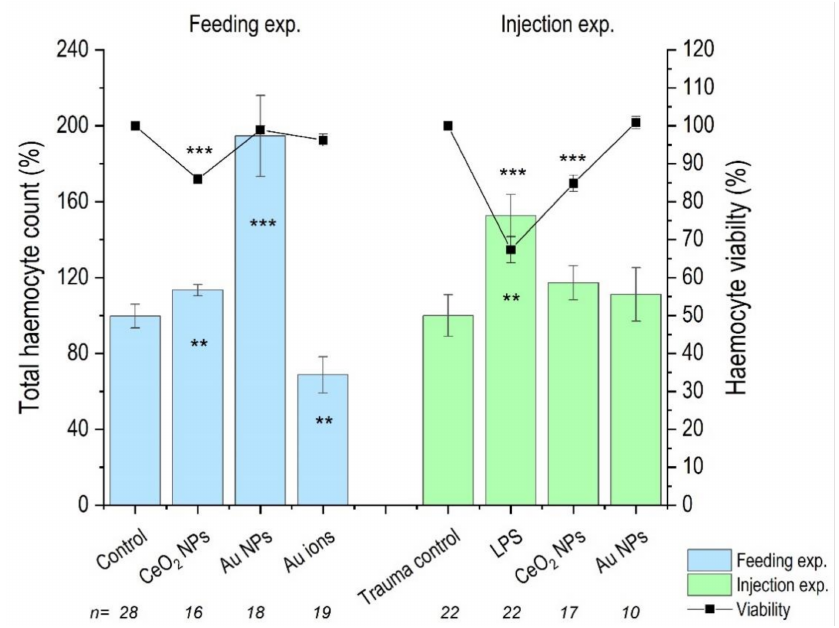
Figure 3. Total haemocyte count (THC) and haemocyte viability in P. scaber exposed to CeO 2 NP- and Au NP-spiked leaves (Feeding exp.) and injected with CeO 2 NPs and Au NPs dispersion (Injection exp.). Au ions correspond to AuCl 3 , trauma control are animals injected with dH 2 O and LPS; animals injected with 50 µ g/ µ L. Columns represents mean ( ± SE). n represents the number of biological repeats. (**) p ≤ 0.01, (***) p ≤ 0.001 in comparison to control (Kruskal–Wallis test followed by Mann–Whitney U-test). When * is drawn inside the column, it refers to THC